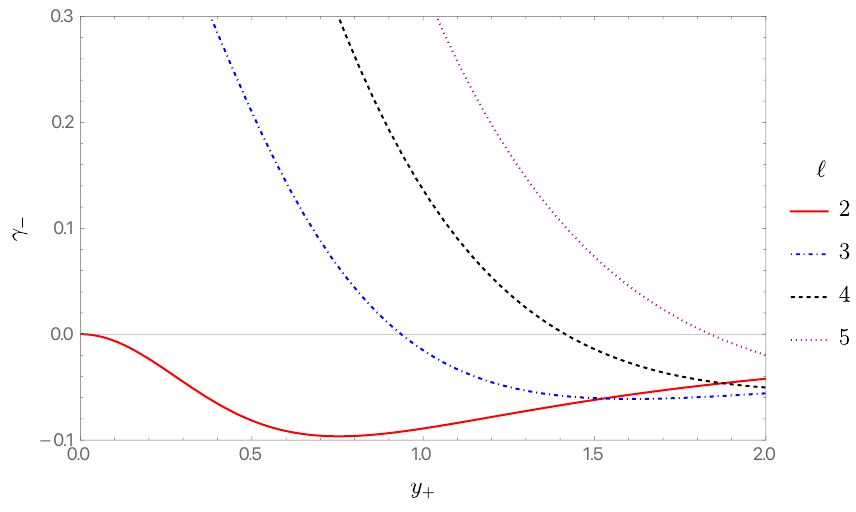
Figure 2 . The scaling exponents γ − for perturbations of AdS 2 × S 3 , as a function of y + = r + /L , computed for several values of ‘ shown on the legend on the